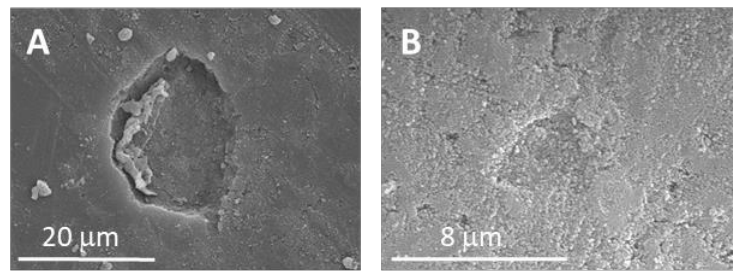
Figure 5. Resorption cavities left by osteoclasts on hydroxyapatite disks after 7 days in coculture with osteoblasts in the presence of 50 μg/mL of either MBGNs ( A ) or MBGN/IPs ( B ) observed by scanning electron microscopy.